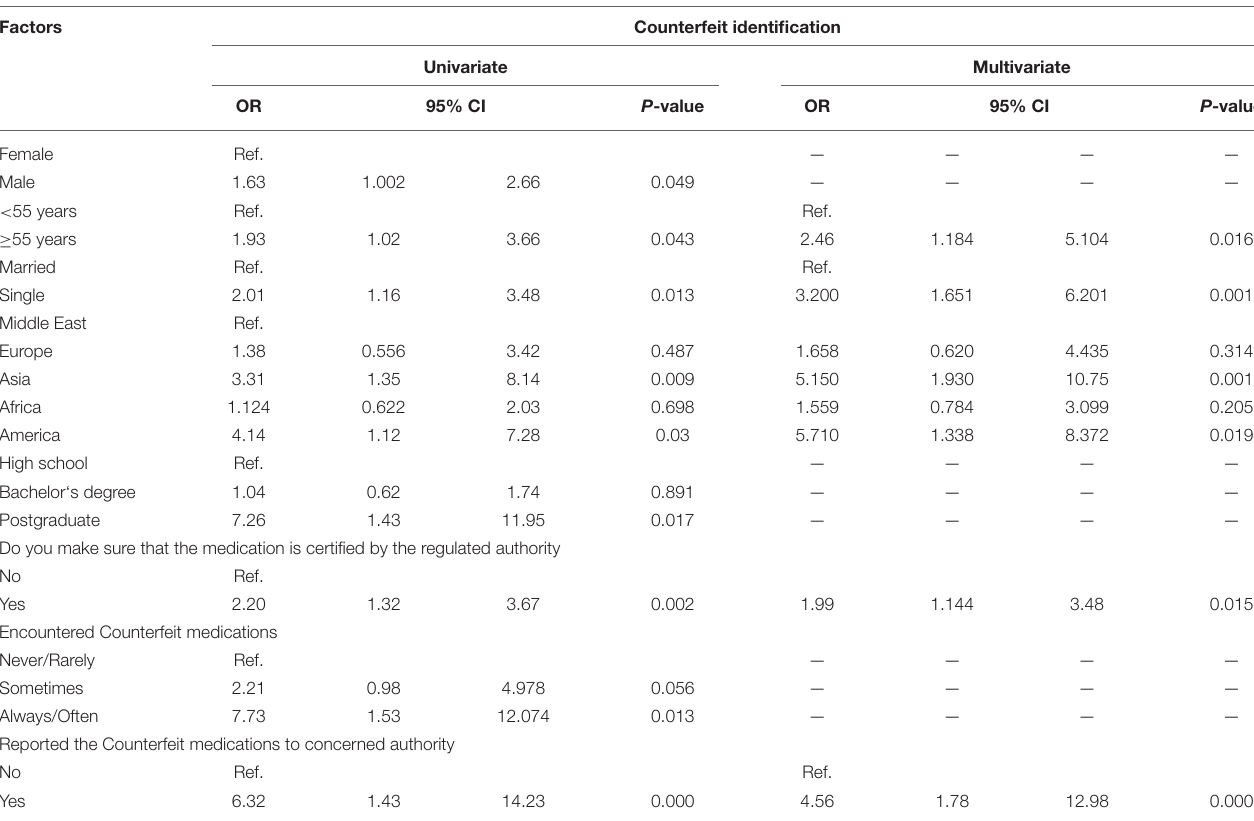
TABLE 6 | Univariate and multivariate analysis of factors associated with counterfeit